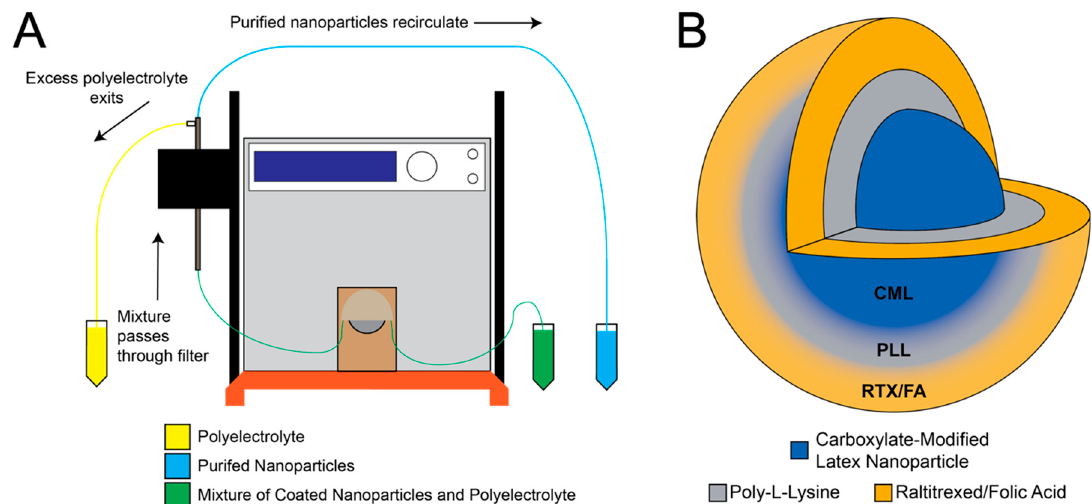
Figure 1. Tangential flow filtration (TFF) allows for rapid purification after layering of various materials onto the surface of carboxylate modified polystyrene latex (CML) nanoparticles (NPs). ( A ) Schematic representation of TFF system used to purify CML from poly- L -lysine (PLL), followed by separation of the NPs from raltitrexed (RTX) or RTX/folic acid (FA) mixture. ( B ) Illustration of the Layer-by-layer (LbL)-coated NP formulation.